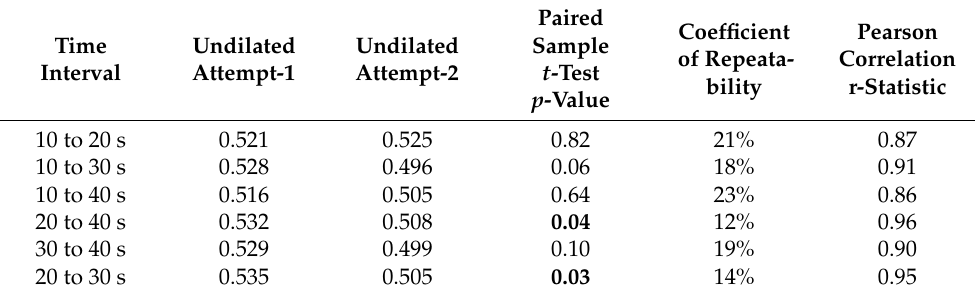
Table 8. Zeaxanthin optical density measurements obtained through physiological undilated pupil- lary conditions.